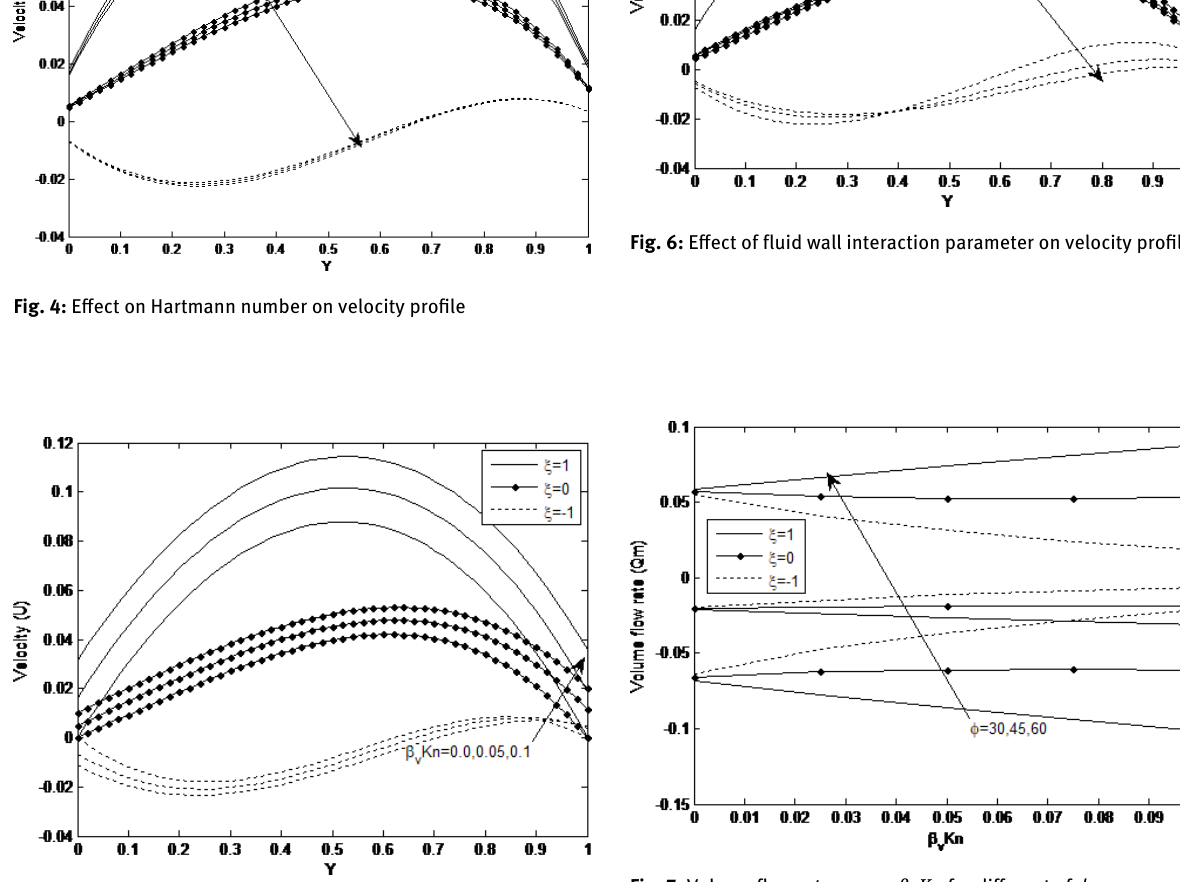
Fig. 5: Effect of rarefaction parameter on velocity